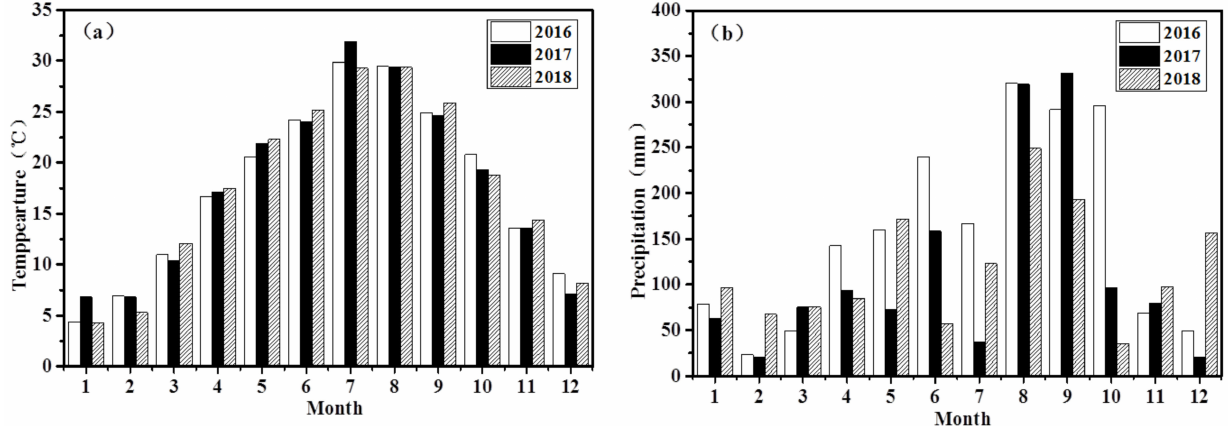
Figure 1. Comparison of average temperature and rainfall in Shanghai from 2016 to 2018. ( a ) Average temperature; ( b ) Average